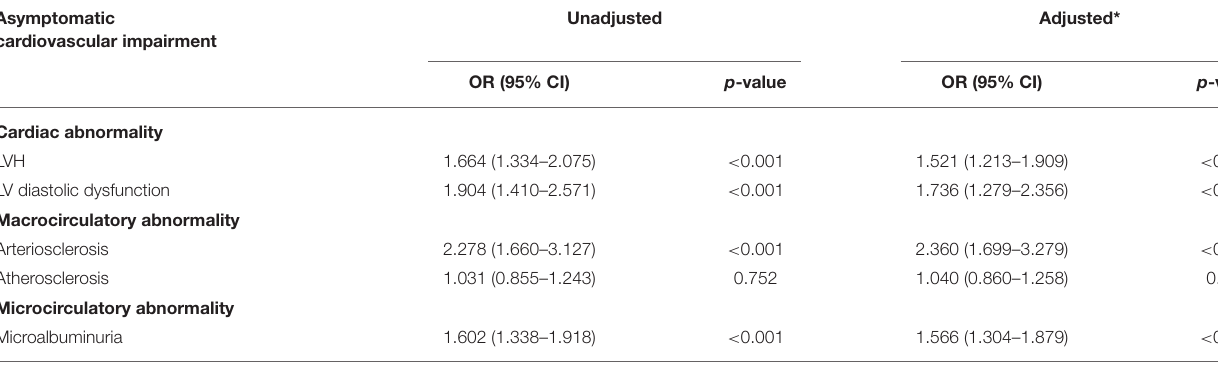
TABLE 3 | Association of various asymptomatic cardiovascular impairments with